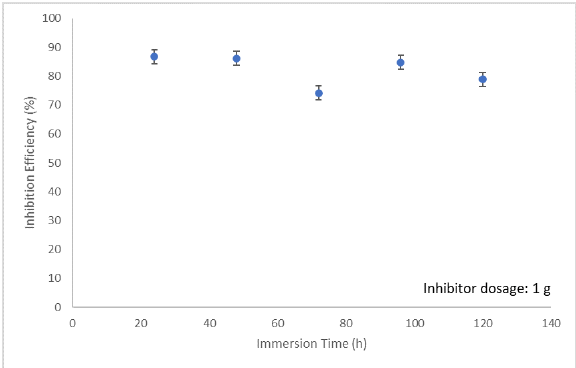
Fig. 3. Effect of immersion time on inhibition efficiency of mild steel acid